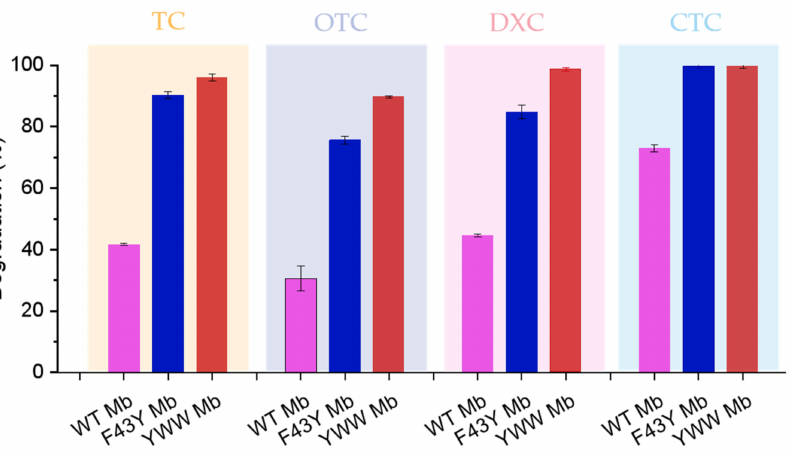
Figure 4. HPLC elution profiles monitored at 280 nm of the reaction solution containing ( A ) TC, ( B ) OTC, ( C ) DXC, ( D ) CTC (100 µ M), respectively, after treatment with WT Mb and its mutants (5 µ M) in the presence of H 2 O 2 (400 µ M) for 5 min.